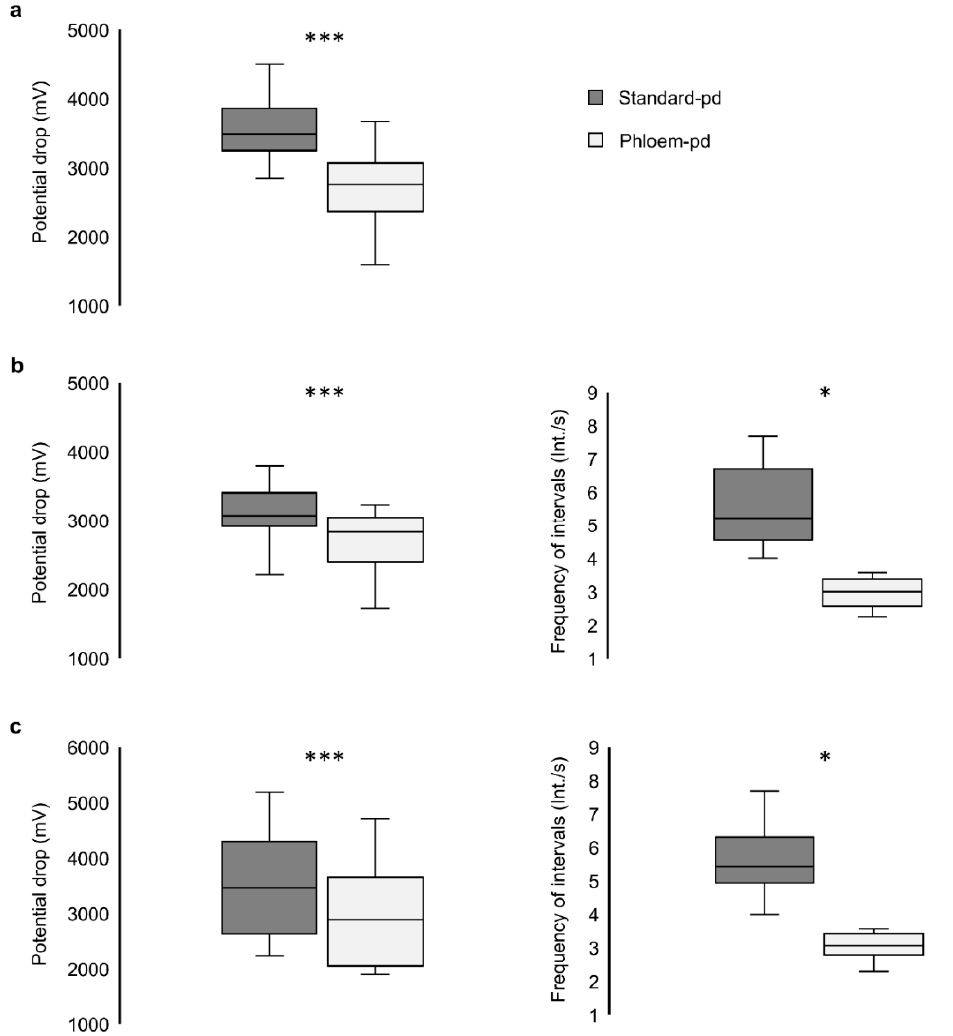
Figure 4. Comparison of the potential drop magnitude and frequency of intervals in subphase II-2 between standard and phloem-pd. The phloem-pd characteristics were compared with previous standard-pd along the recording of the three treatments including the phloem pd: ( a ) treatment ii ( n = 16), ( b ) treatment iii ( n = 14), and ( c ) treatment iv ( n = 16). Asterisks stand for significant differences between variables according to a Student’s paired t test or a Wilcoxon test (***, p < 0.001; *, p < 0.05).